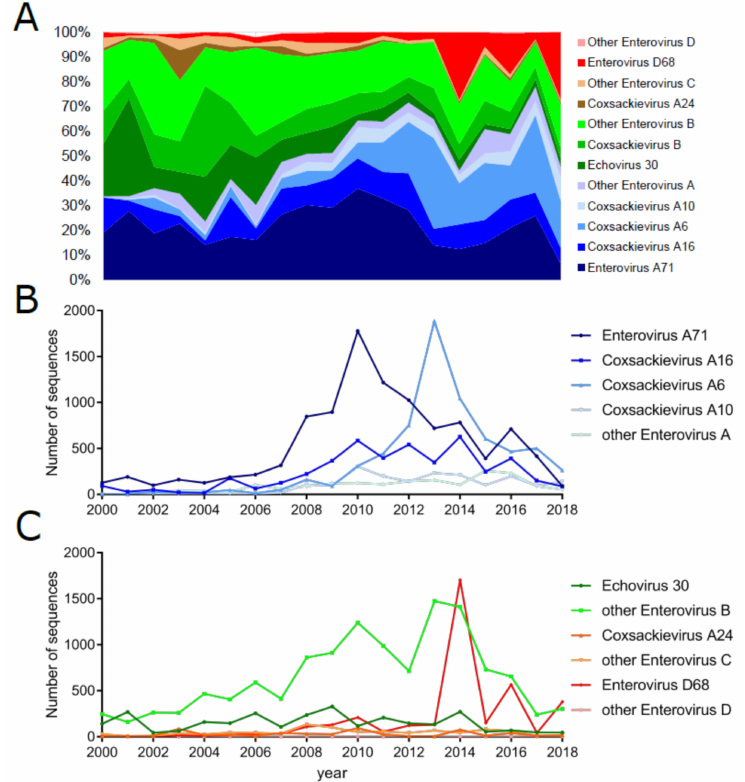
Figure 4. Enterovirus sequence representation from 2000 to 2018 by type. The sample collection calendar year (if available) of all non-polio enteroviruses A (blue), B (green), C (brown), and D (red) sequences. The percentage of each type collected during each year is given in panel ( A ). The numbers of sequences collected from the most common types of EV-A and EV-B, -C, and -D are displayed in panels ( B ) and ( C ), respectively. Data were obtained using the ViPR database, as described in Table 1